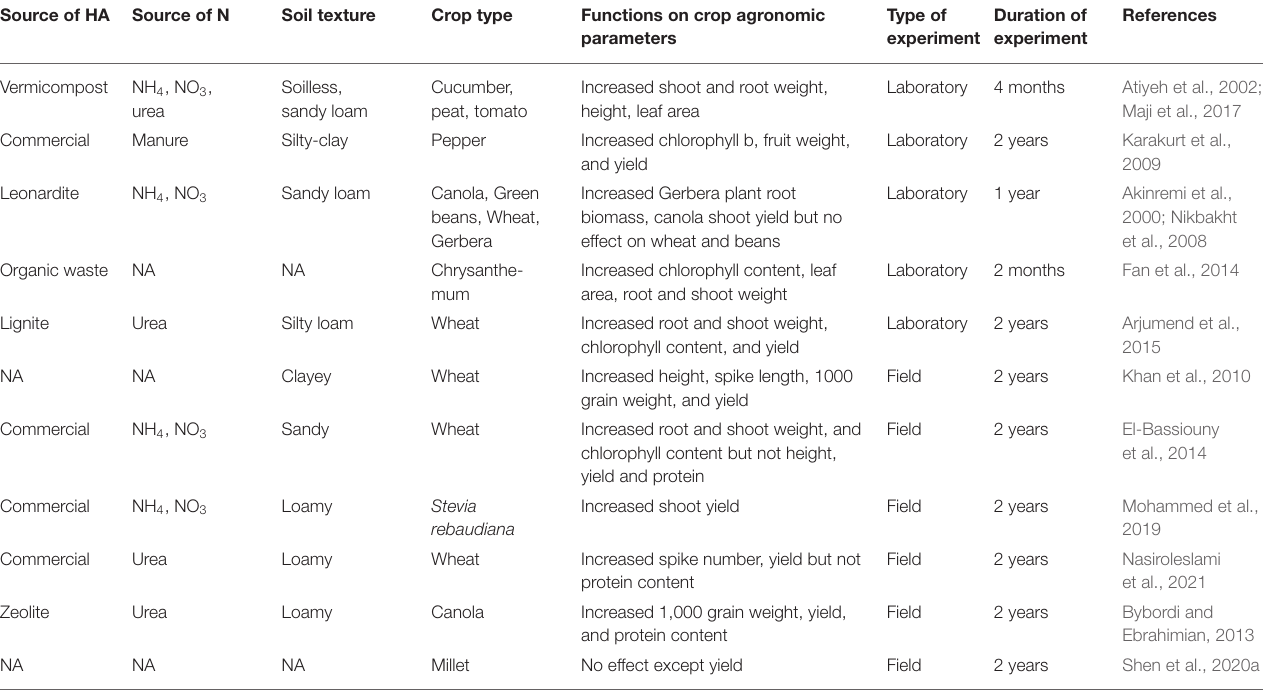
TABLE 2 | Summary of humic acids effects on crop agronomic